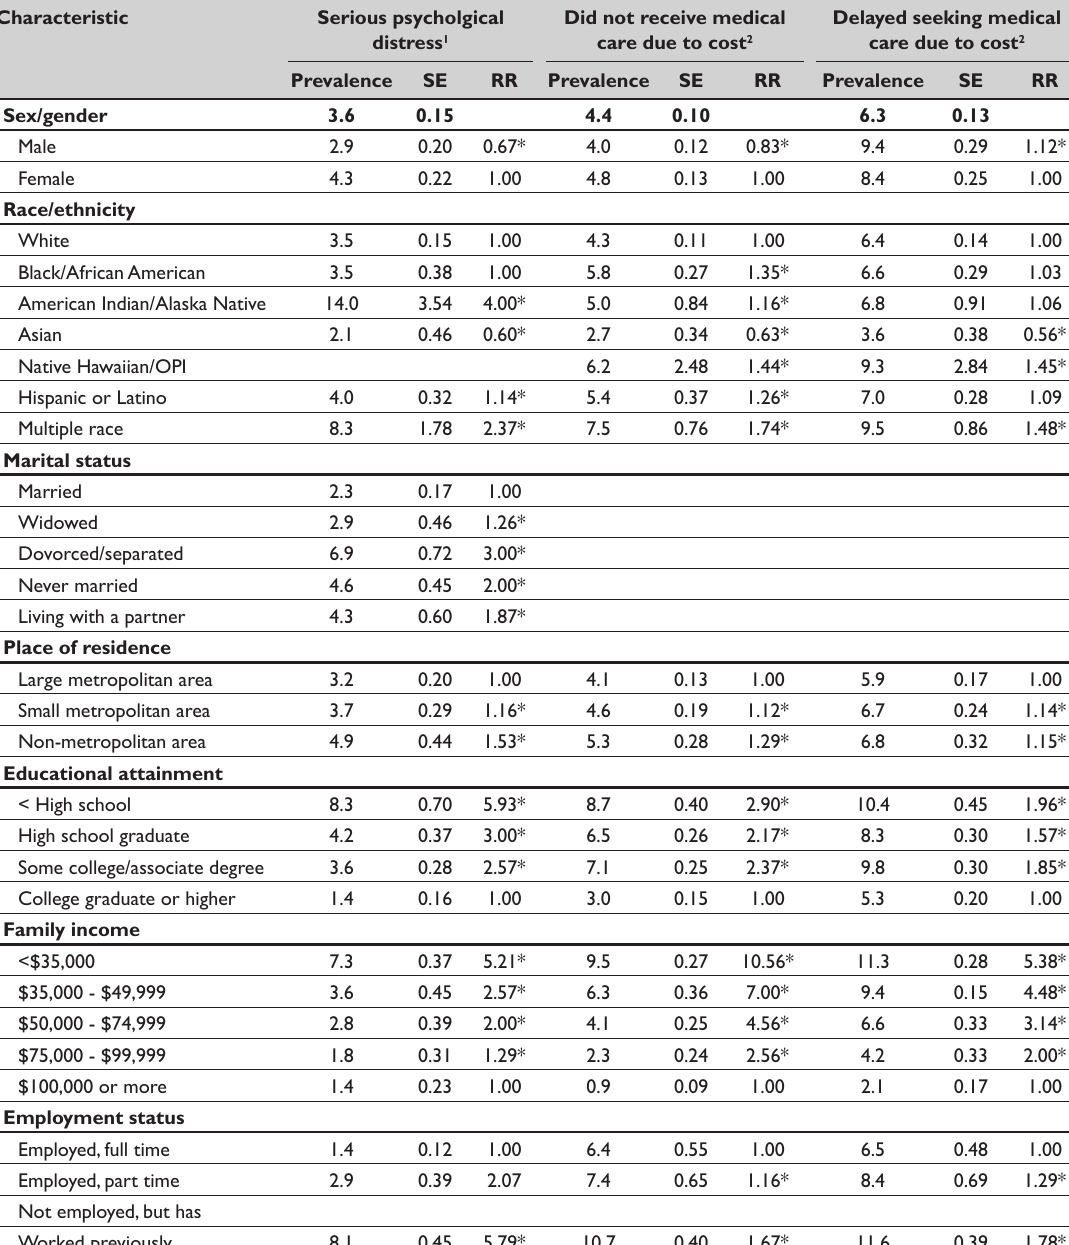
Table 3: Age-adjusted prevalence (%) of serious psychological distress and unmet medical need among US population by sociodemographic characteristics: 2015 National Health Interview Survey